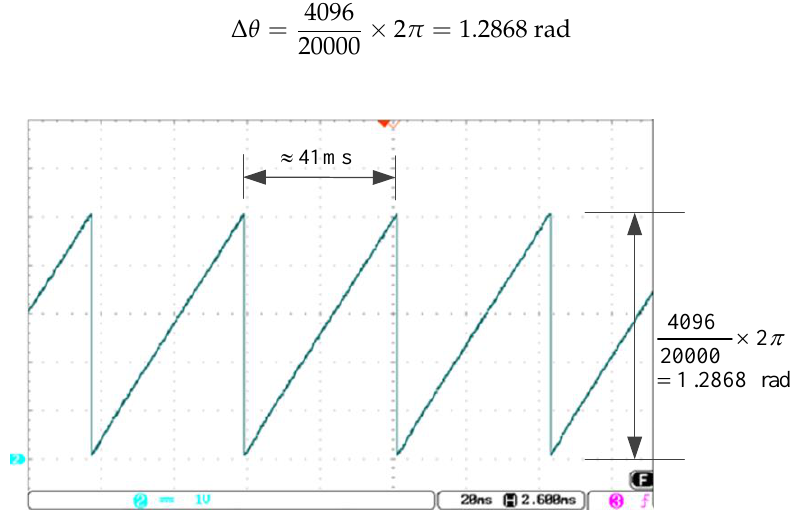
Figure 15. The output of position counter by DAC for the speed command of 300 rpm.